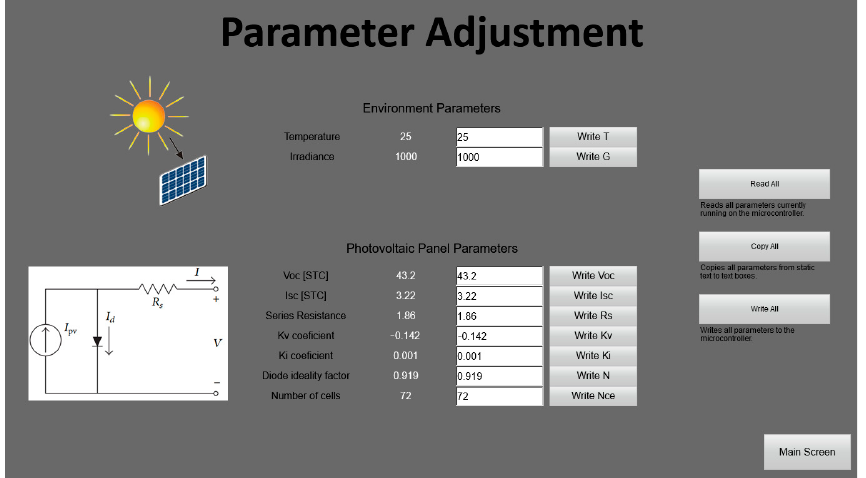
Figure 22. SCADA software layout developed to introduce parameters of the SPV panel, including temperature and irradiation.